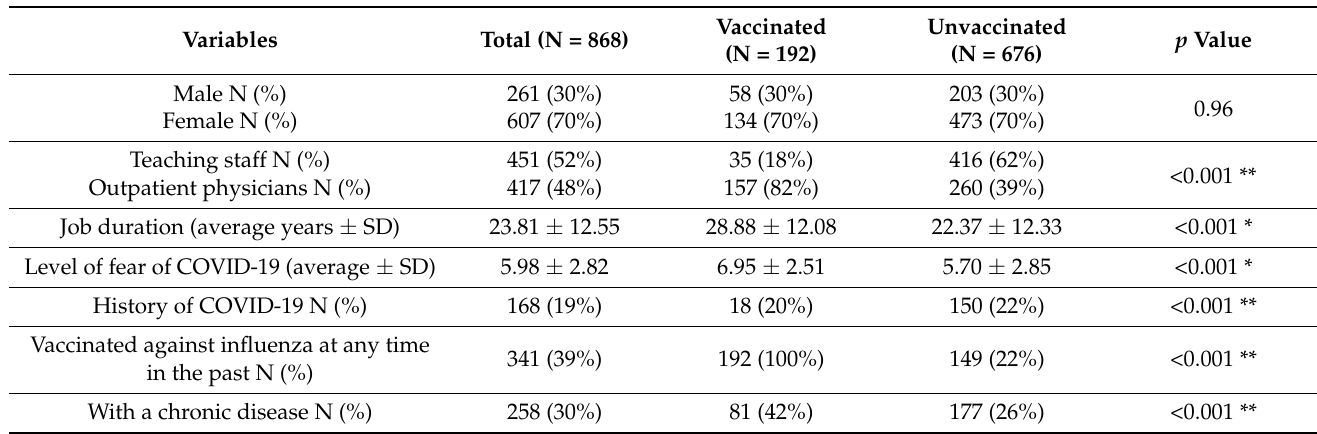
Table 2. Socio-demographic characteristics of respondents simultaneously vaccinated against COVID- 19 and influenza (last season).